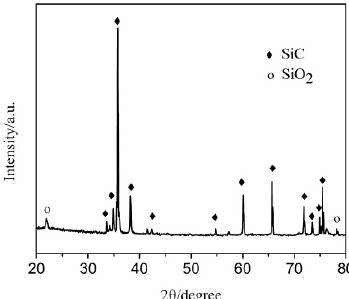
Figure 1. XRD pattern of the SiC coated C/C sample before oxidation.